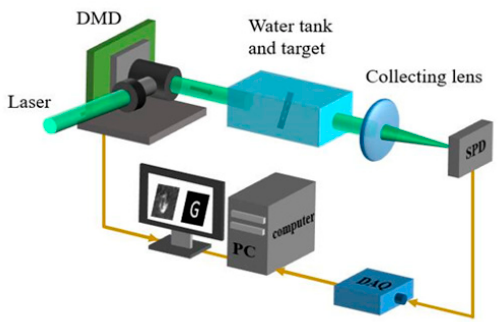
Figure 7. Schematic diagram of the underwater object detection system.